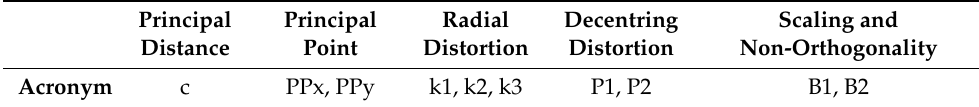
Table 2. Camera parameters estimated in the BBA.